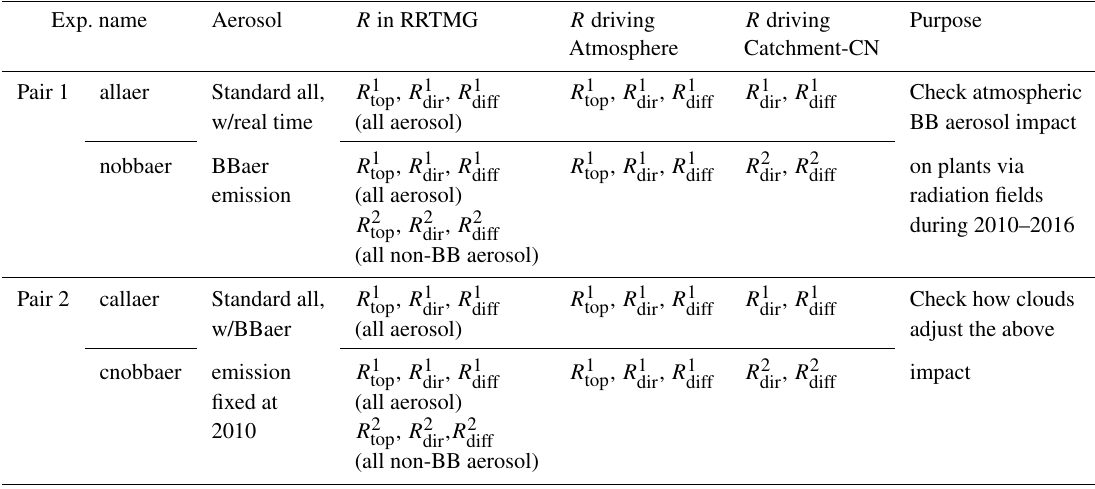
Table 1. Designed experiments (2010–2016) with their perturbation on aerosol fields and subsequent impact on radiation and ecosystem. “dir”: direct; “dif”: